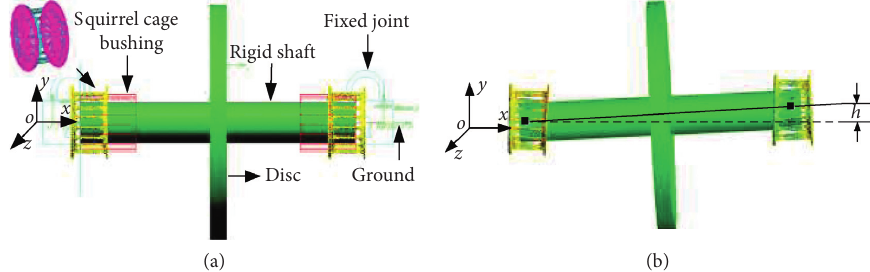
Figure 7: Rigid-flexible coupling model. (a) Normal condition. (b) Misaligned